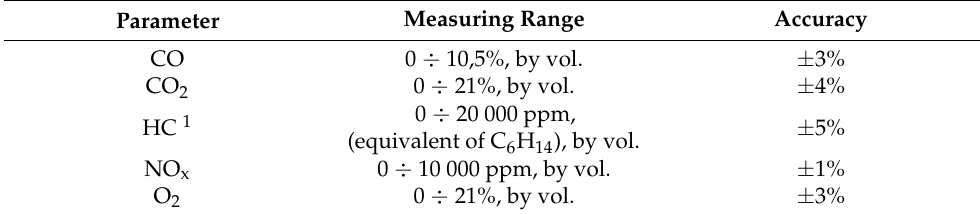
Table 4. Measurement range and accuracy of the exhaust gas analyzer.